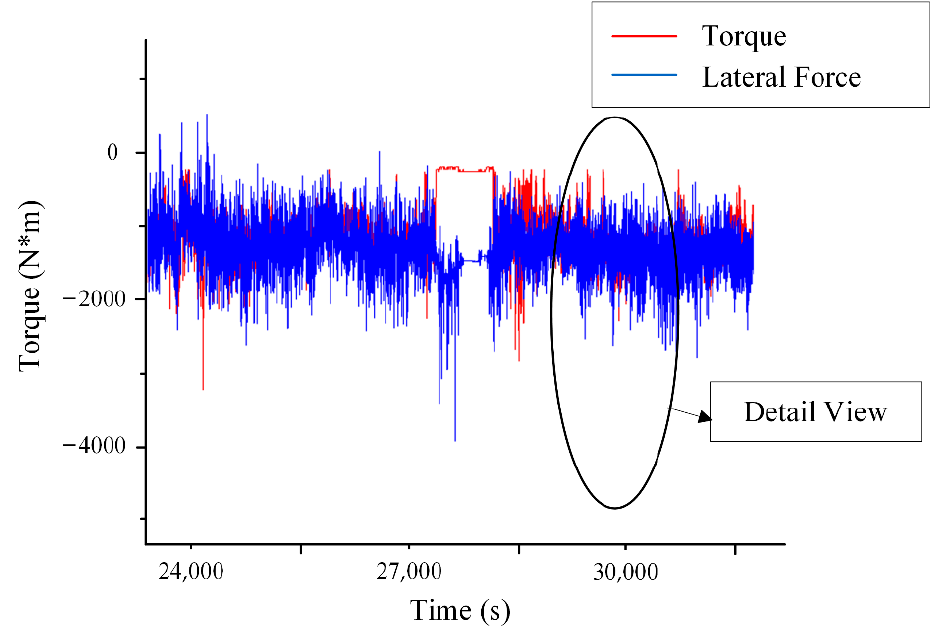
Figure 12. Relationship between the lateral force and the torque.